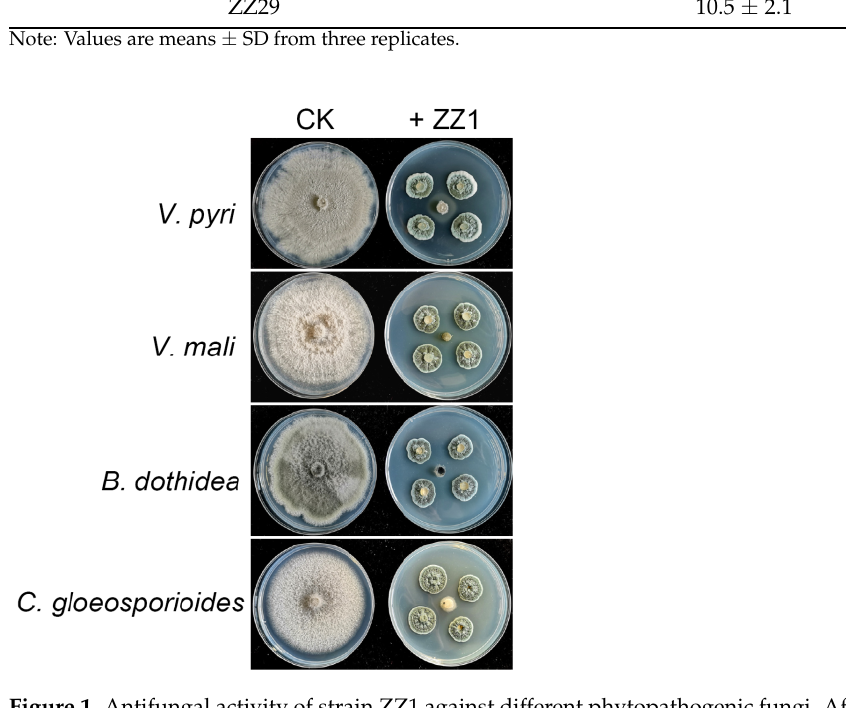
Figure 1. Antifungal activity of strain ZZ1 against different phytopathogenic fungi. After inoculation with ZZ1 for 2 days, a mycelial plug (5 mm in diameter) of the pathogenic fungal isolate was placed in the center on PDA medium. The pictures were taken at 6 days after inoculation.